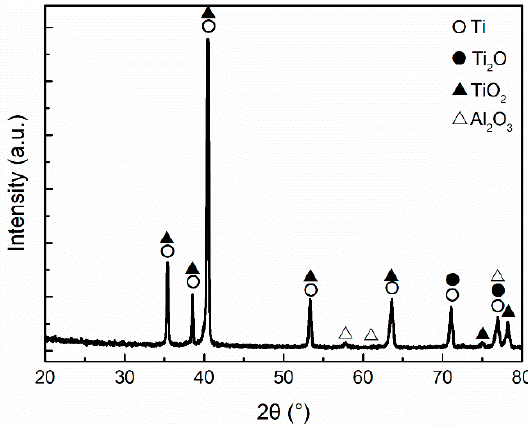
Figure 15. XRD diffractogram of Ti-6Al-4V alloy after hot corrosion for 88 h.